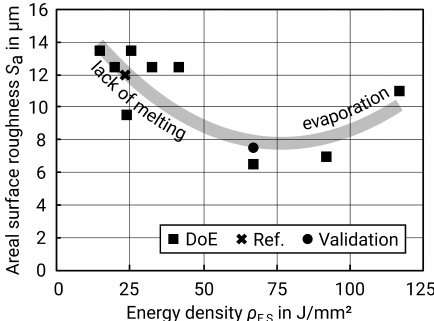
Figure 7. Surface roughness S a versus energy density ρ E,S for contour surfaces (including nine values as a result of the design of experiments (DoE), one value as a reference (see Table 4), and one value from the validation; grey line for clarification purposes only).